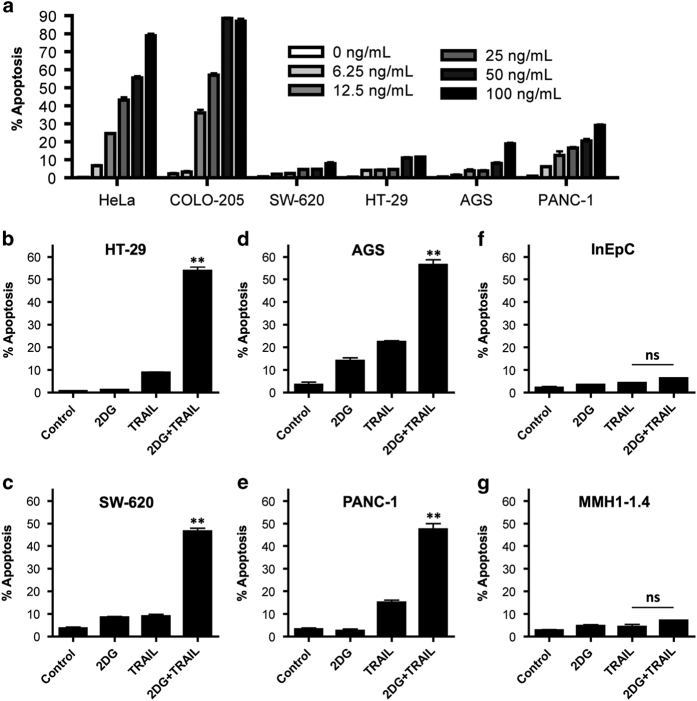
2DG synergizes with TRAIL to induce cell death in TRAIL-resistant cancer cell lines but not in normal cells. (a) HeLa cells (positive control) are sensitive to TRAIL-induced apoptosis; however, the majority of human colon (HT-29, SW-620), stomach (AGS) and pancreatic cancers (PANC-1) tested were TRAIL resistant. (b–e) TRAIL sensitization upon treatment with 2DG. (f, g) Nonmalignant cell controls (InEpC, normal human intestinal epithelial cells; MMH1-1.4, hepatocytes) show no effect of 2DG treatment on TRAIL-induced apoptosis. Apoptosis is detected by caspase-3 activation. n=3, and was validated with Annexin V+PI and TMRM staining (Supplementary Figure S1). ** indicates P<0.01, ns indicates P>0.05.